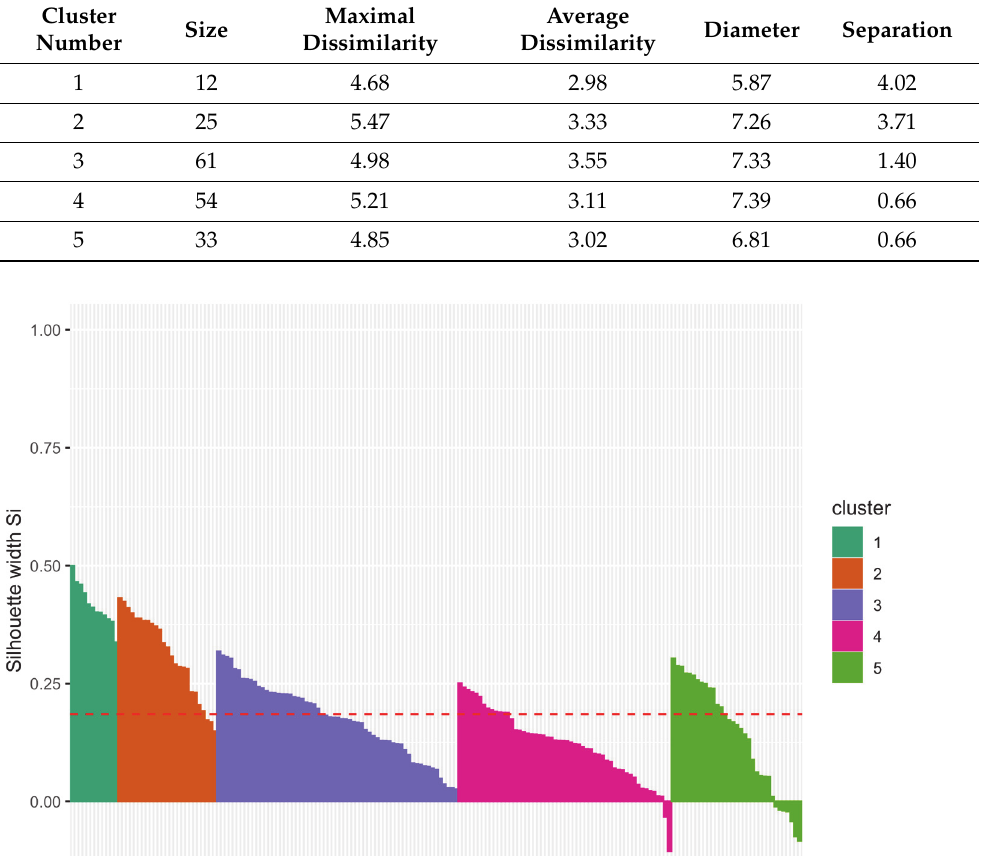
Figure 4. The result of the k ‐ median clustering algorithm. The different shades indicate the clusters into which the observations were classified, while shapes indicate the corresponding stages in the wastewater treatment. The components listed on the graph axes are those created using the t ‐ SNE method.